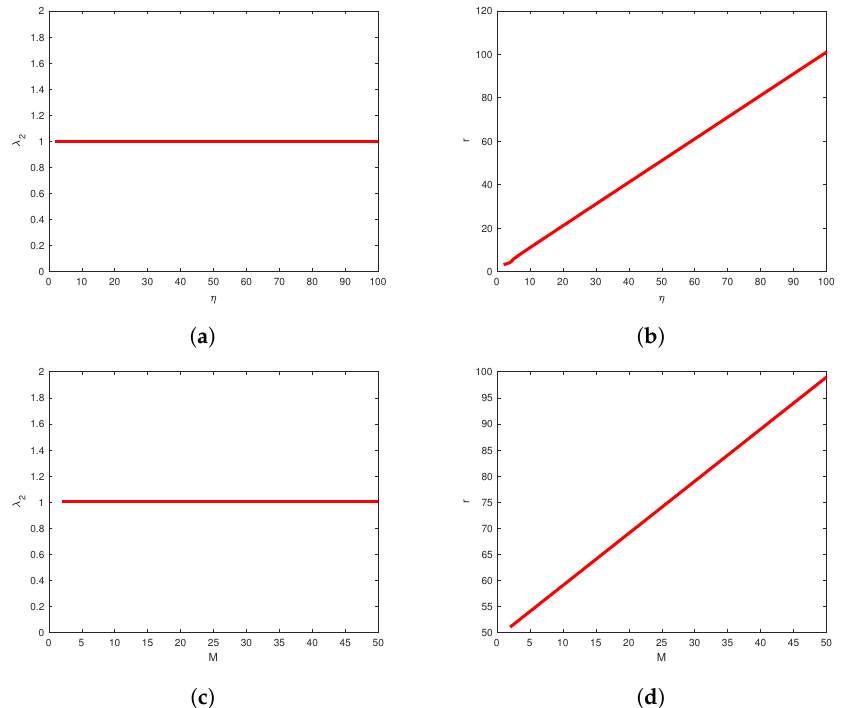
Figure 9. The synchronizability of Networks-C. Panel ( a ) depicts λ 2 vs. η and ( b ) depicts r vs. η when a = 1, d = 1, M = 2; Panel ( c ) depicts λ 2 vs. M and ( d ) depicts r vs. M when a = 1, d = 1, η =